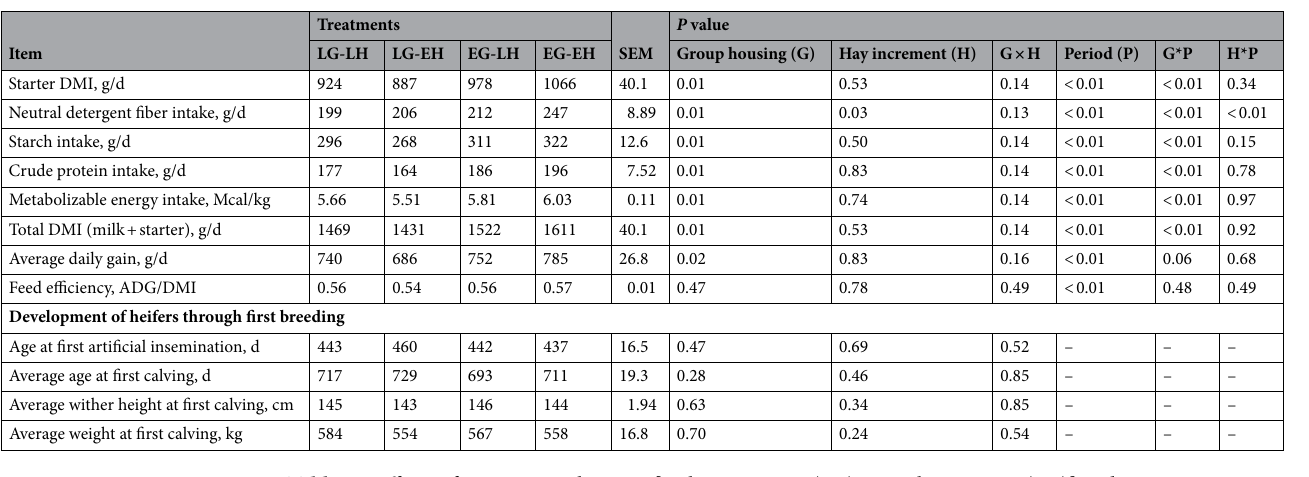
Table 2. Effects of age at group housing [G; late grouping (LG) vs. early grouping (EG)] and age at incremental hay supplementation [late hay increment (LH) vs. early hay increment (EH)] on starter dry